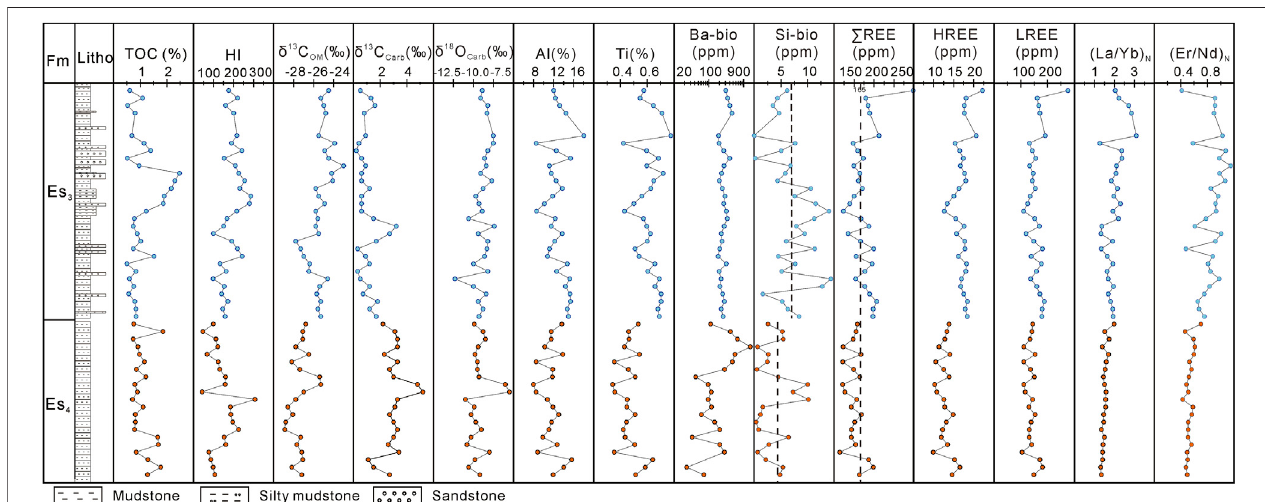
FIGURE5 | Geochemical pro fi le showingthe changes inorganic matter abundance, isotopic compositions, some majorelementcontents,calculated productivity proxies,and therare earthelement compositions.Thesampleswerelisted inorderofdepth(details werelistedin Table1 ).Thebrokenlinerepresents theaveragevalue of the corresponding contents. Two negative values of Ba-bio and Si-bio ( Table 1 ) were replaced by zero. Abbreviations for the titles of corresponding contents were listed in Table 1 and Table 2 .